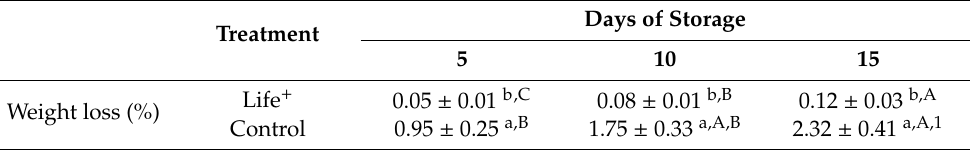
Table 1. Weight loss of sweet cherries stored at 6 ◦ C for 15 days.